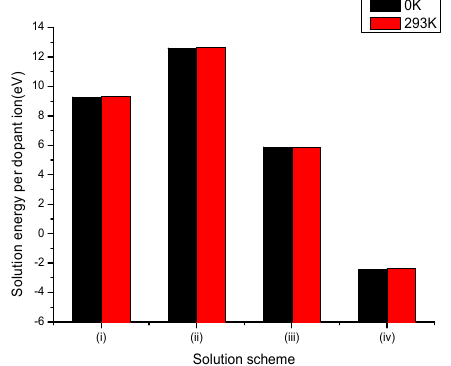
Figure 6. Bar chart of solution energies vs. solution schemes for pentavalent dopant (V 5+ ) at the Li and Nb sites, considering the first neighbours in relation to the c axis.